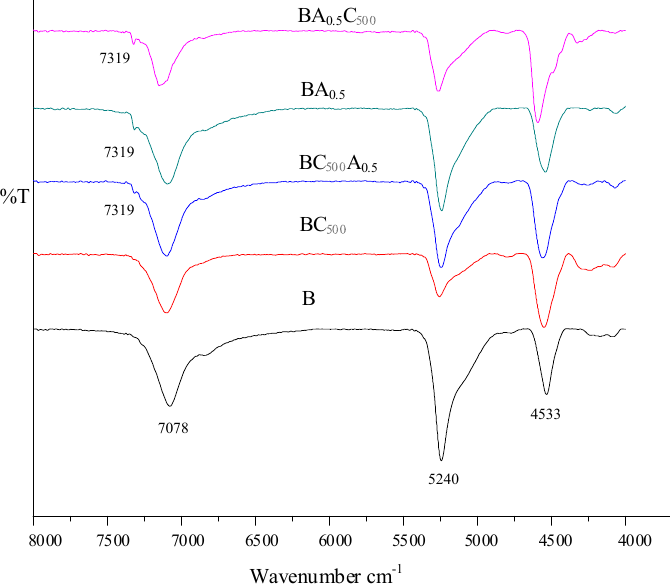
Figure 3. NIR FT - IR spectra of bentonite (B), BC 500 , BC 500 A 0 . 5 , BA 0 . 5 and BA 0 . 5 C 500 samples. Figure 3. NIR FT-IR spectra of bentonite (B), BC